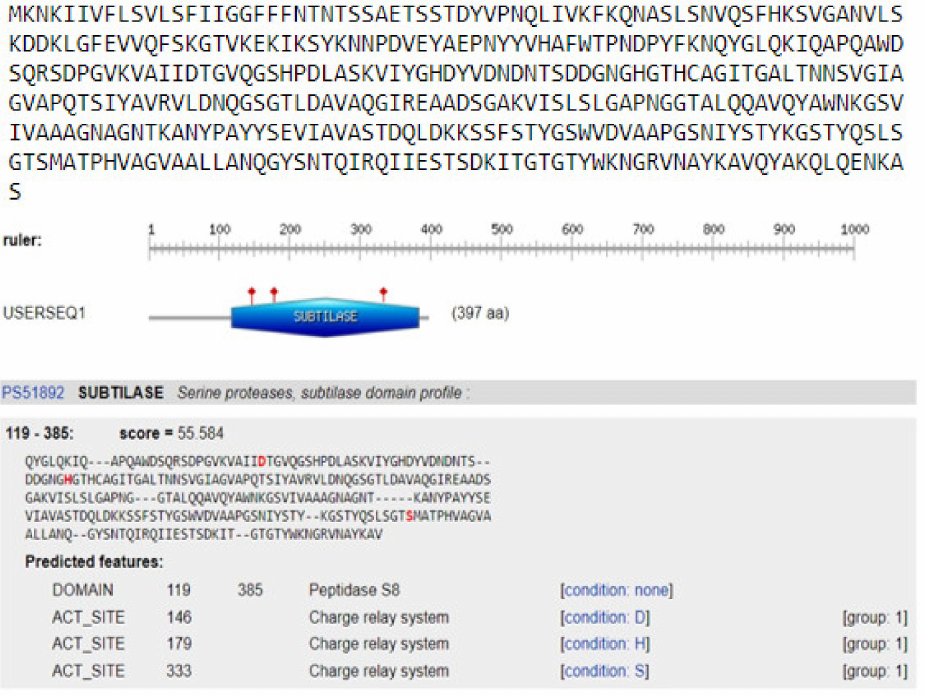
Figure 10. Prediction of the catalytic domain and active sites of keratinase gene KerS 13. The catalytic triad subtilase ASP146, subtilase HIS179 and subtilase SER333 with a score of 55.5. Using InterProScan and NCBI conserved domains search, our KerS showed similarity to peptidases S8 thermitase-like (thermitase-like domain) at position 110–368 (Figure 11). Thermitase is a serine protease belonging to family S8 (subtilases) [53], which includes subtilisin isolated from Bacillus species. Thermitase is a thermostable serine proteinase that is more stable against thermal denaturation and proteolytic degradation than most members of the family [54]. Furthermore, pairwise alignment comparison revealed a high identity between KerS gene and two thermostable serine proteases; thermophilic serine proteinase B. cereus (B3ZJ21) and thermitase alkaline serine protease B. cereus retrieved from the UniprotKB database (95.58% and 99.09%, respectively). Interestingly, the mutant KerS 13uv+ems shared the highest identity with thermitase alkaline serine protease (100%). However, thermophilic serine proteinase B3ZJ21 showed the highest identity with KerS 13 (95.78%). KerS 26uv shared 95.48% and 97.59% identity with thermophilic and thermitase protease, respectively. According to Li et al. [47], the keratinase gene ( kerT 1) shared over 70% identity with the peptidase S8 thermitase family domain and possibly belongs to the serine